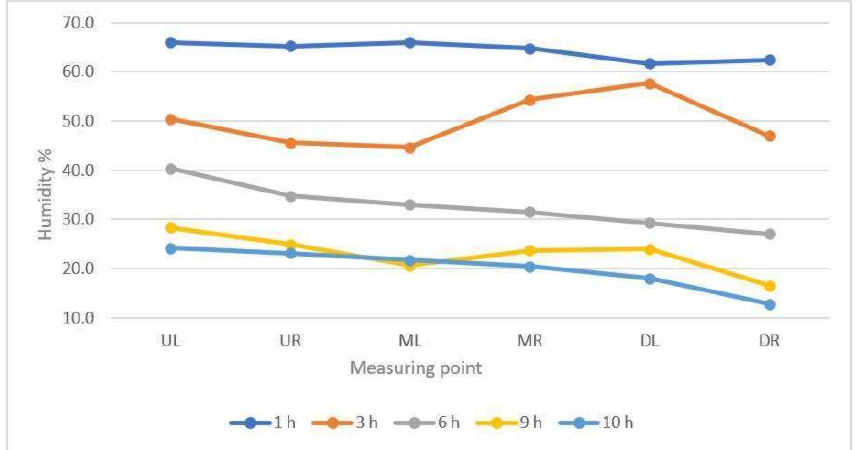
Figure 10. Change in moisture content of beef samples, taken from different zones in the drying chamber, chamber 1.